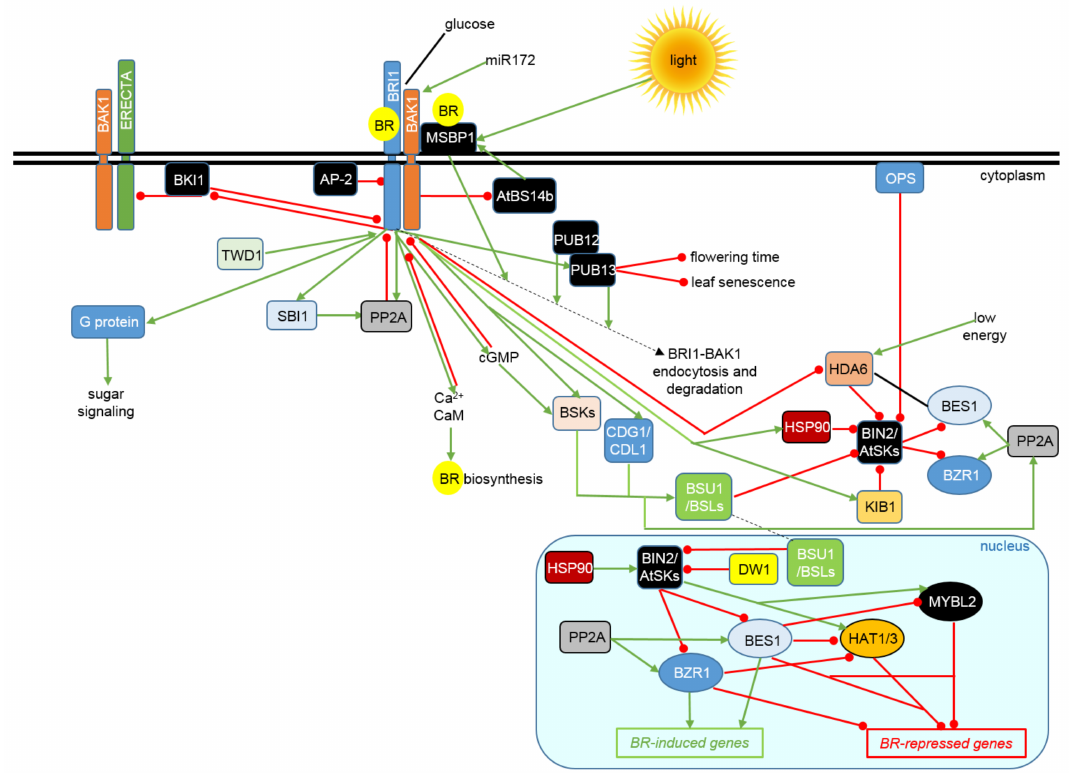
Figure 1. Model of the BR signaling regulation and control of the BR-dependent gene expression. Transcription factors are shown as ovals, other proteins are depicted as rectangles. Double black line represents the plasma membrane. Green arrows indicate stimulation, whereas red lines with the bullet points represent suppression. Detailed description is given in the